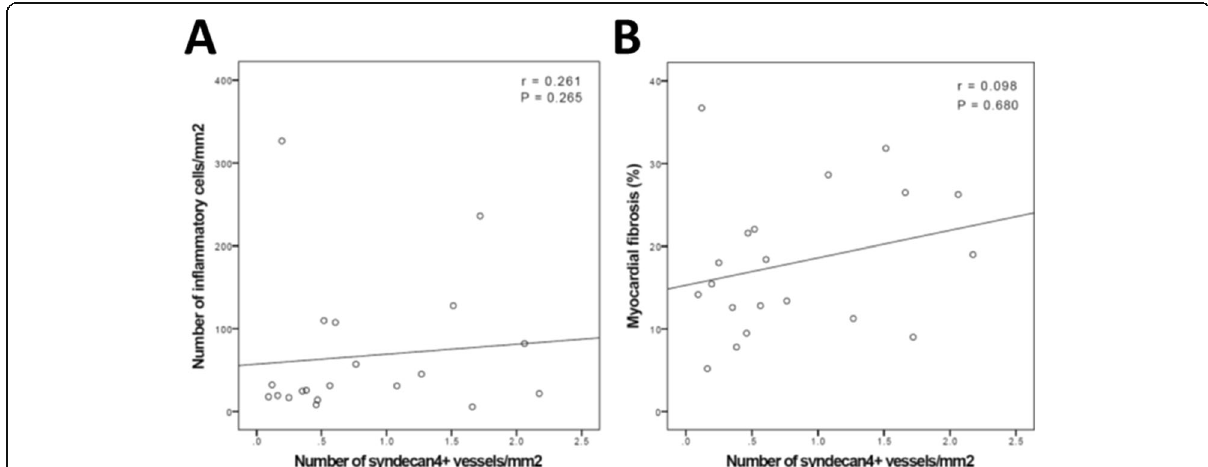
Fig. 7 Analysis of correlation between syndecan-4 expression, inflammation and fibrosis in explanted hearts from subjects with end-stage cardiomyopathy. a , Correlation between syndecan-4 + blood vessels/mm 2 and number of inflammatory cells ( n = 20, Spearman ’ s correlation). b , Correlation between syndecan-4 + blood vessels/mm 2 and percentage of myocardial fibrosis ( n = 20, Spearman ’ s